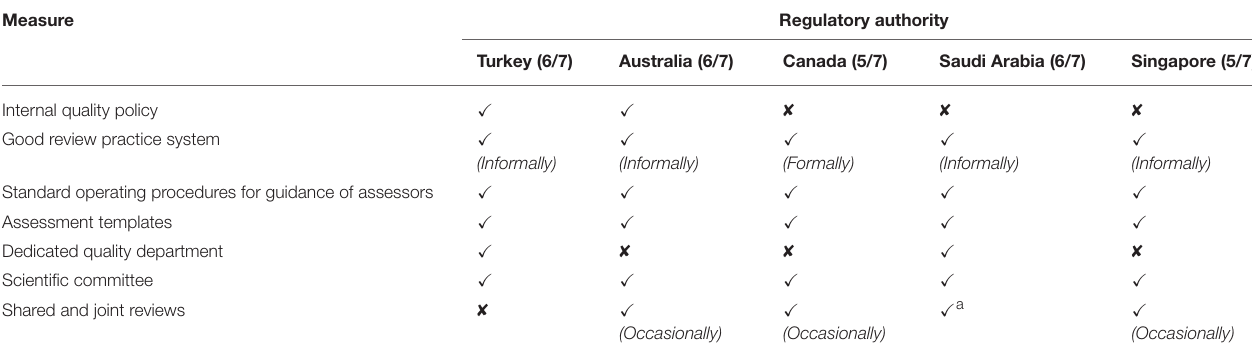
TABLE 2 | The quality measures implemented by the five agencies.